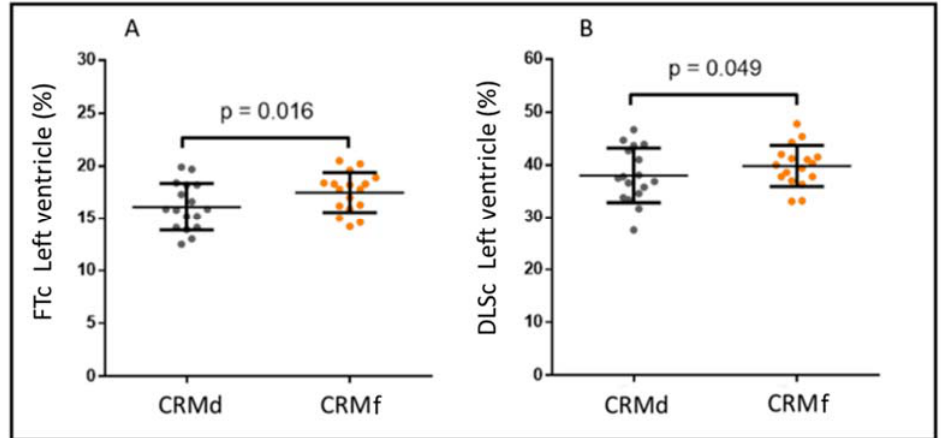
Figure 2. Analysis of the global circumferential feature tracking (FTc) ( A ) and global circumferential deep learning ‐ based strain (DLSc) ( B ) in the diagnostic (CMRd) and follow ‐ up (CMRf) cardiac magnetic resonance imaging.